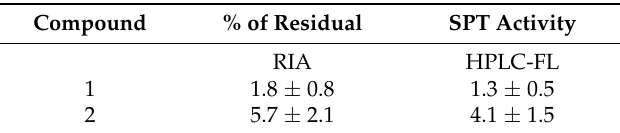
Table 2. Screening of compounds 1 and 2 (at a concentration of 50 µ M) on human SPT by RIA and HPLC-FL assay.